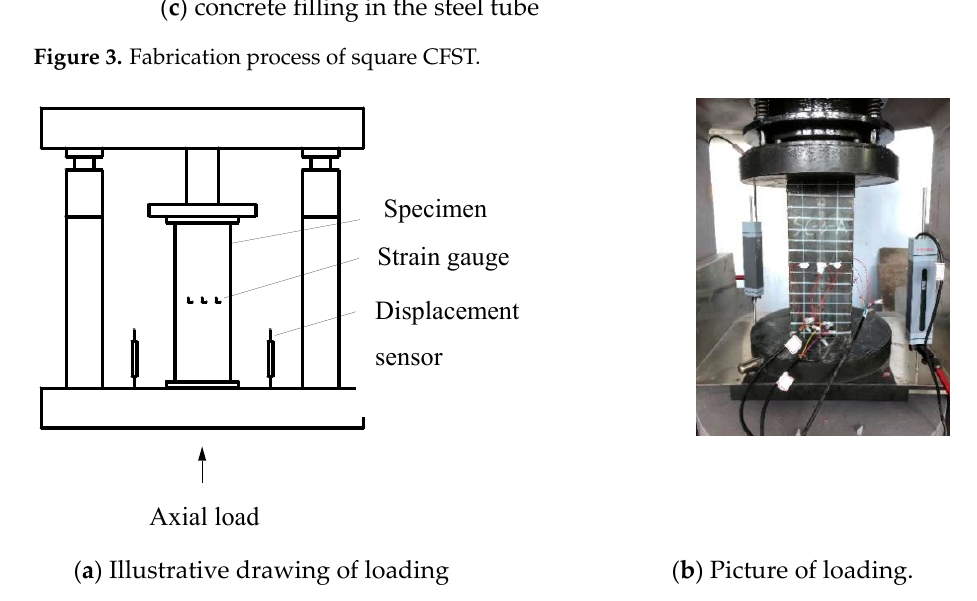
Figure 4. Loading equipment and measuring instrument plan.